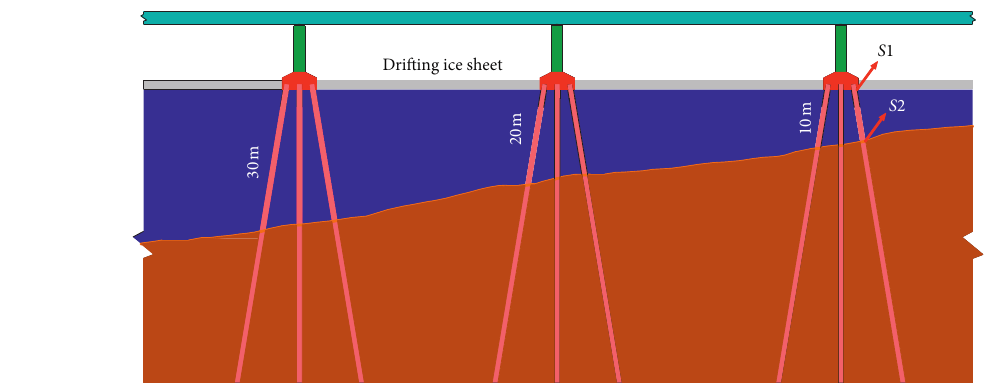
Figure 4: Exhibition of bridge configurations with 10m, 20m, and 30m water depth under ice loads.